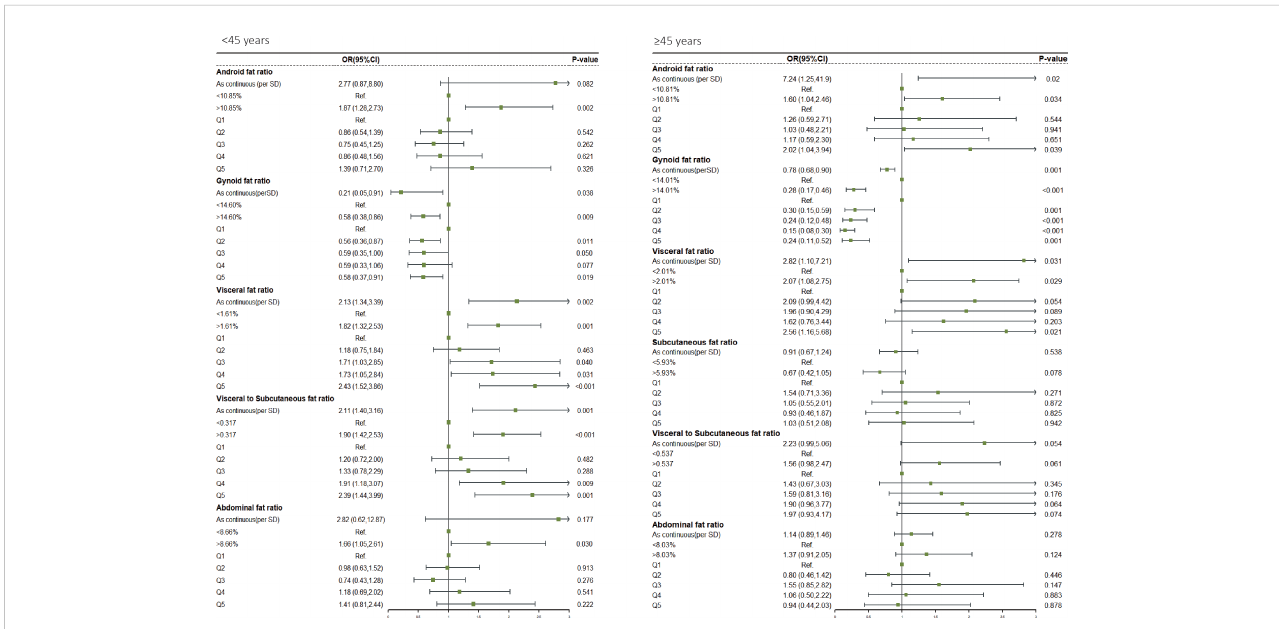
FIGURE 1 Comorbidity risk odds ratio (95% CI) of different fat distribution in obese male.